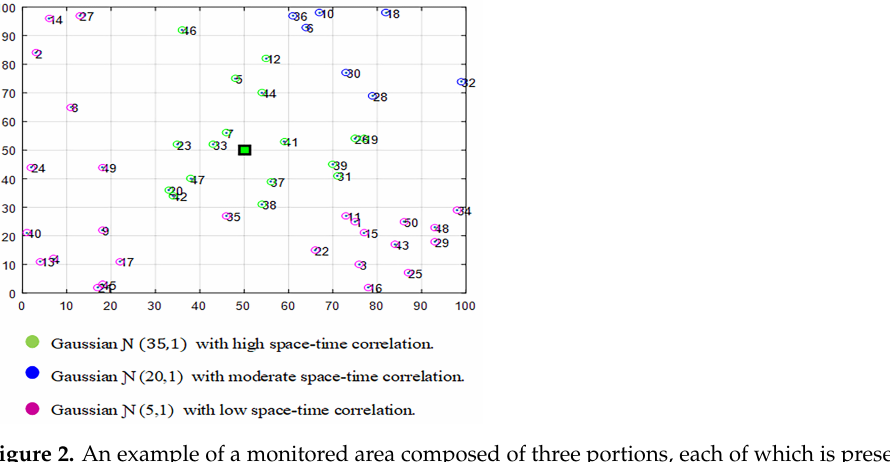
Figure 2. An example of a monitored area composed of three portions, each of which is presented by a different